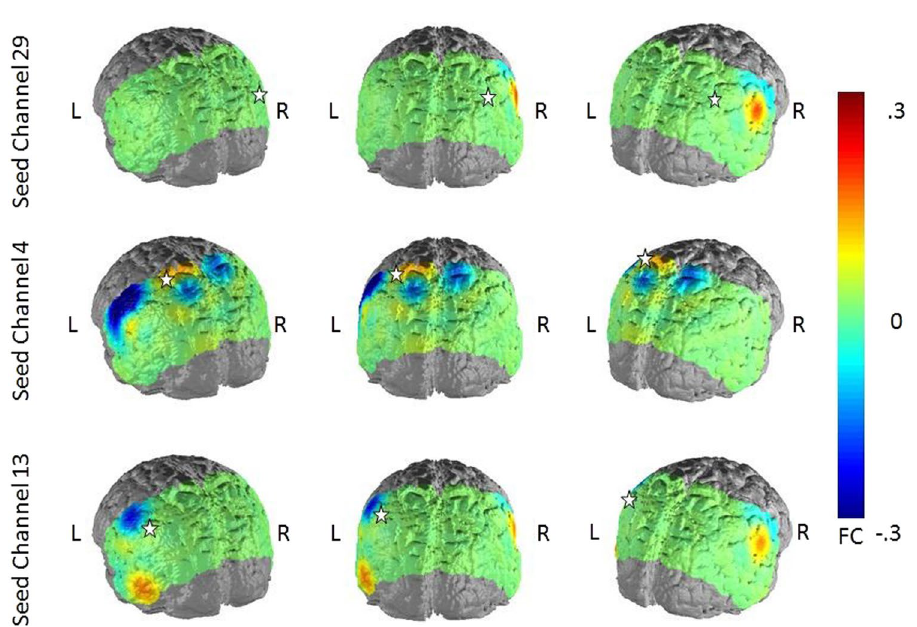
Figure 6. Differences between “depressed low state-ruminators” and “depressed high state-ruminators”. Cold colors indicate lower FC in high-ruminators compared to